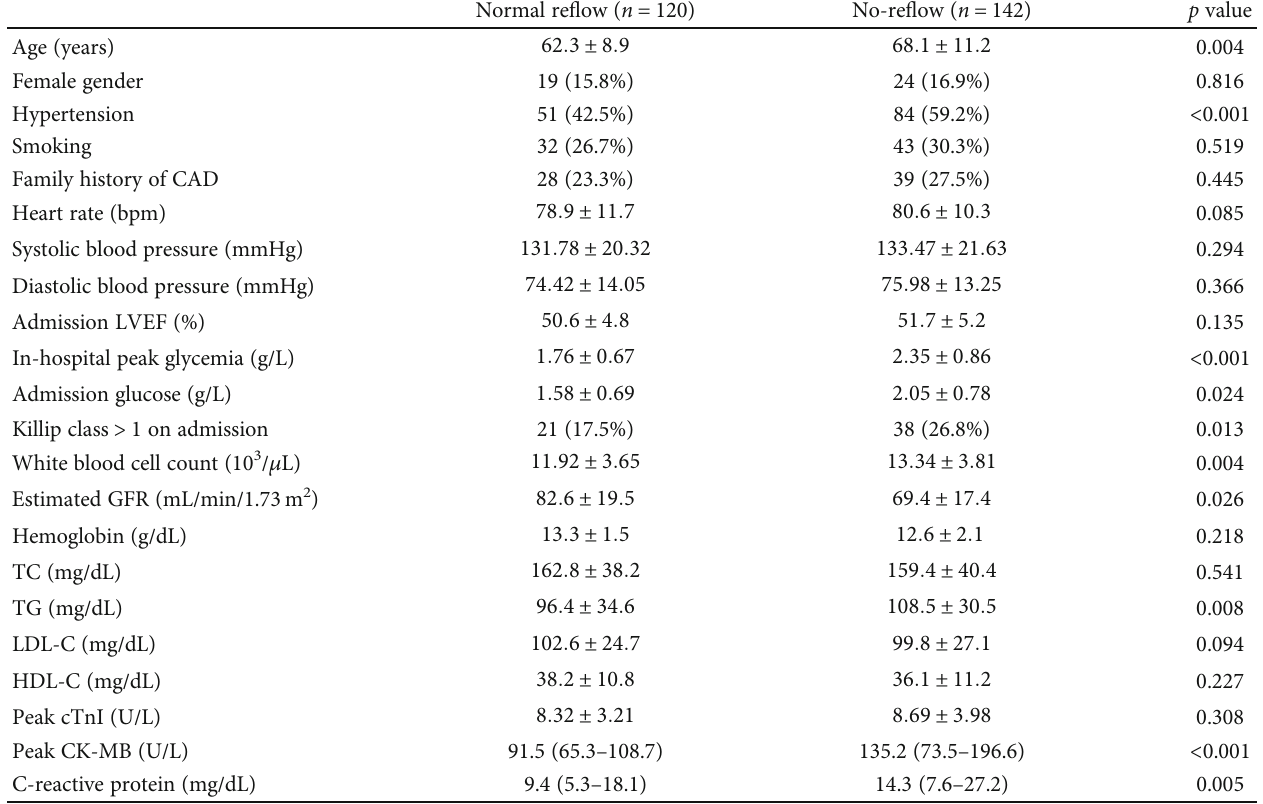
Table 1: The baseline characteristics and laboratory results of patients classi fi ed according to no-re fl